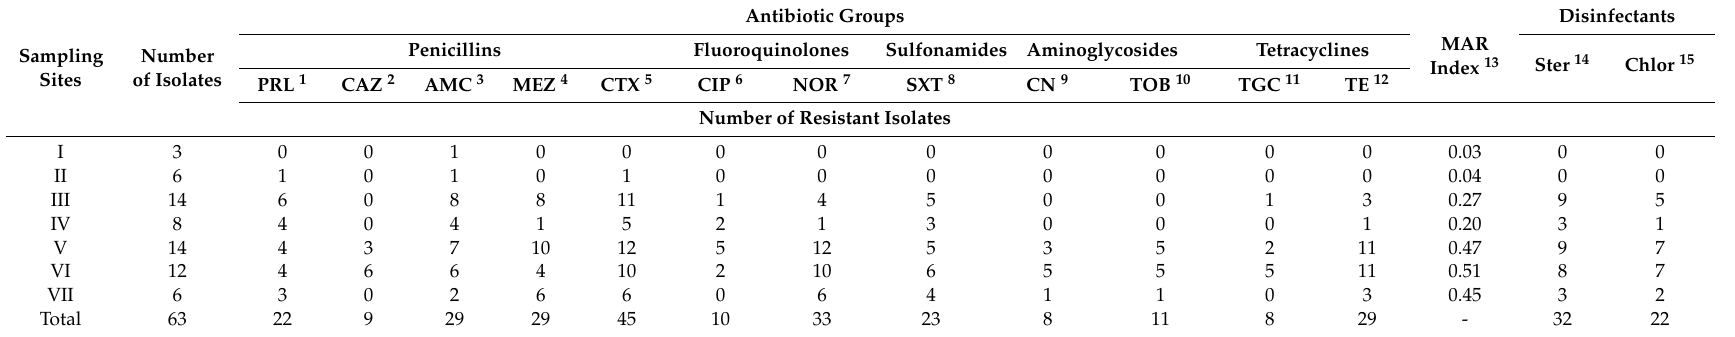
Table 2. Antimicrobial resistance of opportunistic pathogens Pseudomonas fluorescens (OPPF) isolated from the Drw˛eca River.